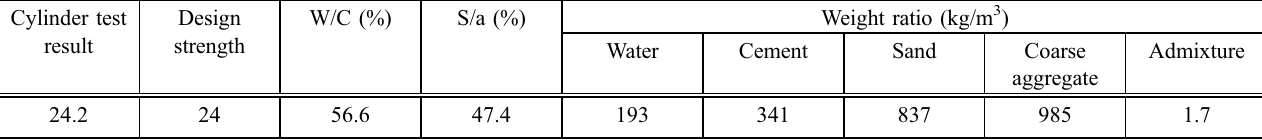
Table 2 Mix proportion of concrete and cylinder test results.